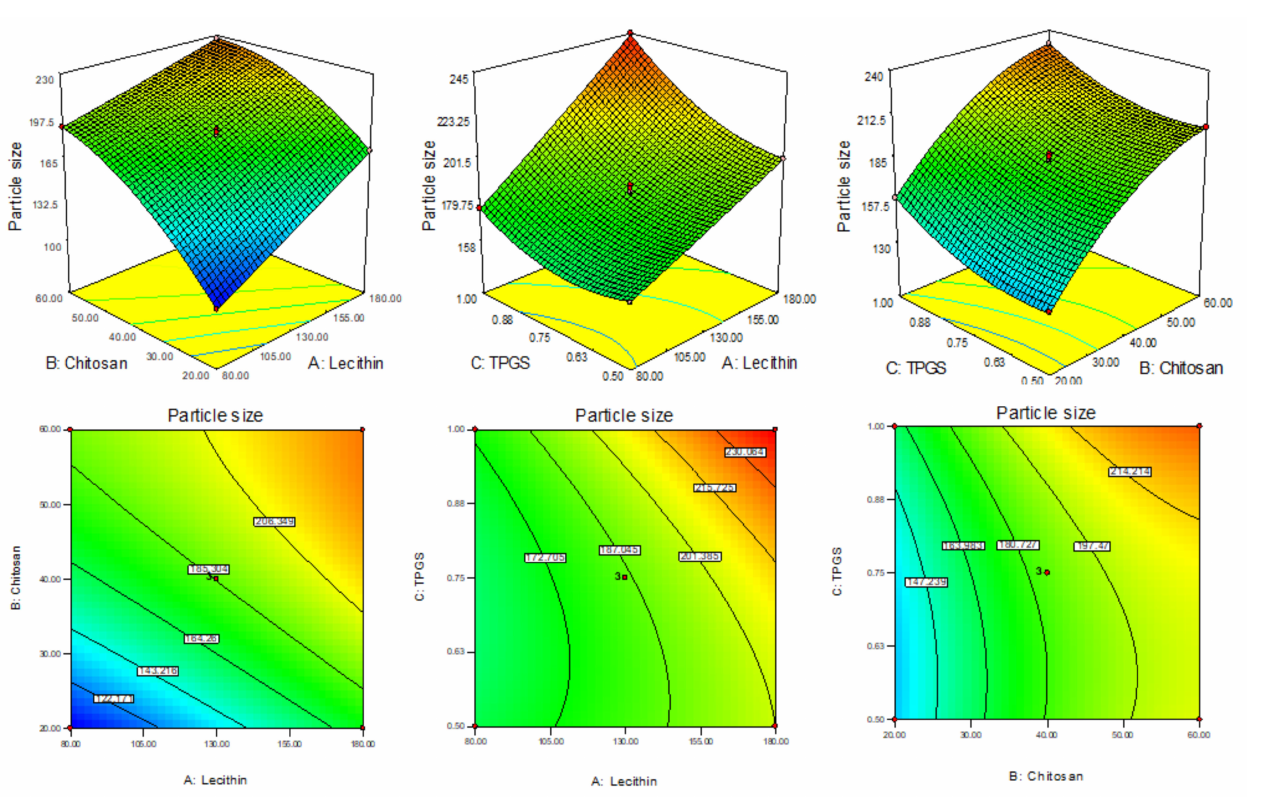
Figure 2. 3D response surface plot showing the effect on independent variables on size (Y 1